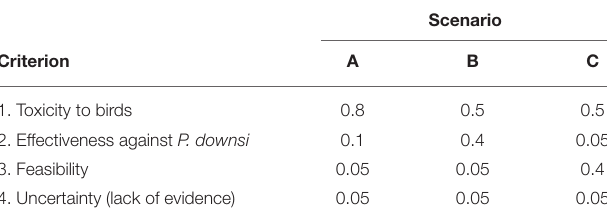
TABLE 3 | Weights for each one of the criteria for each of the three scenarios considered in the risk